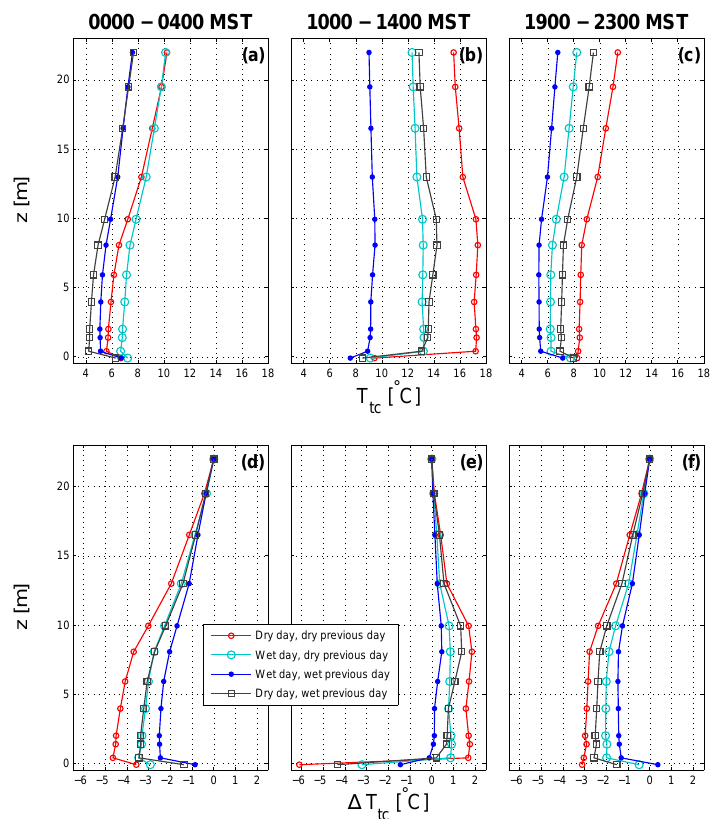
Figure 4. Vertical profiles of mean warm-season thermocouple air temperature T tc and soil temperature T soil (at a depth of 5cm) for (left) nighttime (00:00–04:00MST), (middle) mid-day (10:00–14:00MST), and (right) late evening (19:00–23:00MST). The upper row is the absolute temperature, while the bottom row is the temperature difference relative to the highest level (21.98m). Each line represents a different precipitation state as shown in the legend. These measurements are from the warm season in years